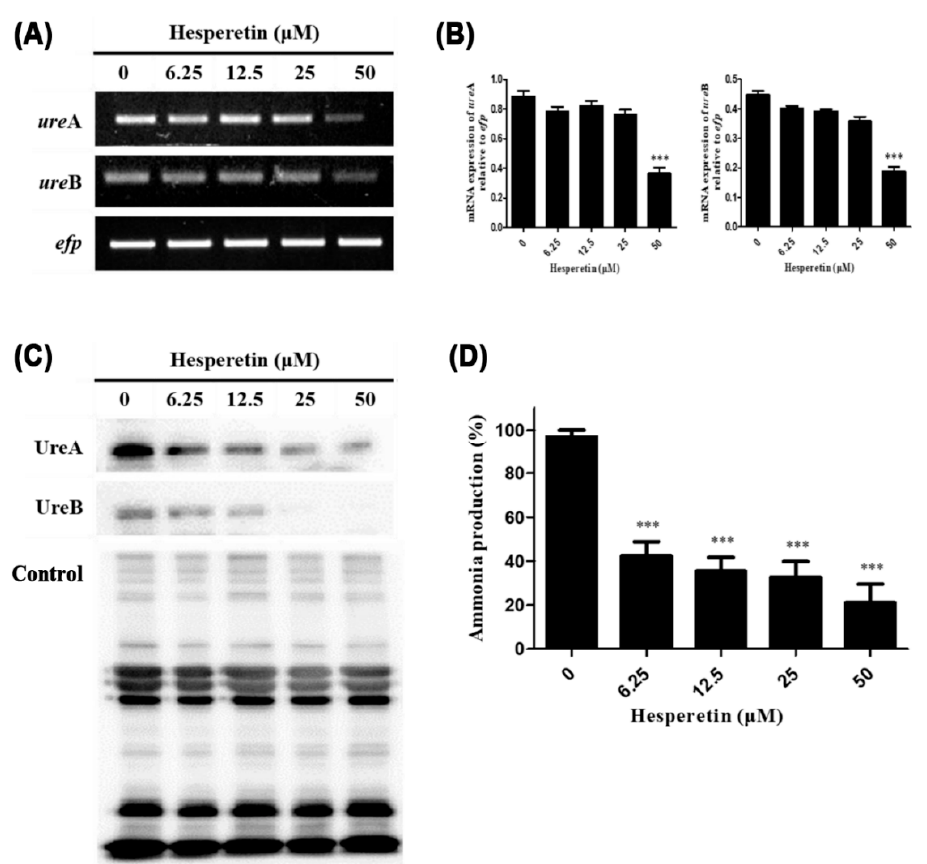
Figure 3. Downregulation of the inhibitory effect of hesperetin on the expression and activity of urease in H. pylori . ( A ) H. pylori was treated with the indicated concentrations (0, 6.25, 12.5, 25 and 50 µ M) of hesperetin. Collected RNA was subjected to RT-PCR to detect mRNA expression levels of urease subunits ( ure A and ure B). The expression of efp was used as an internal control. ( B ) Each band intensity was normalized to efp . ( C ) Bacterial lysates were subjected to Western blotting to detect UreA and UreB proteins. A rabbit anti- H. pylori polyclonal antibody was used as an internal control. ( D ) After 72 h, the supernatant was collected and urease activity was determined by measuring the amount of ammonia. Data are presented as mean ± SEM of triplicate experiments and were analyzed by Student’s t -test (*** p < 0.001).